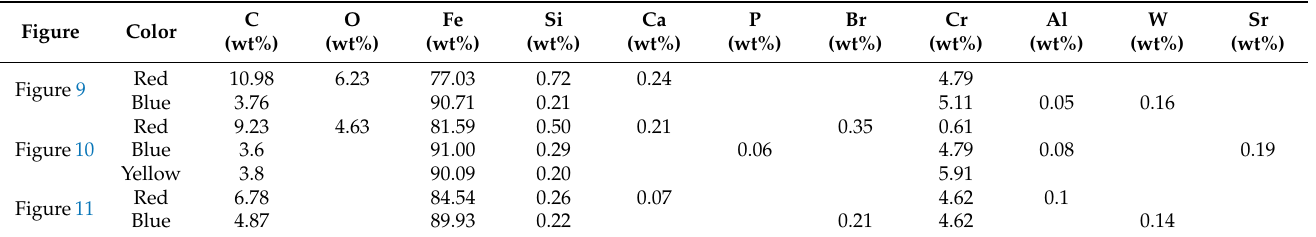
Figure 12. EDS of the wear delamination of bearings’ rolling elements (unserviced). Table 2. EDS of the wear delamination of high-performance bearings’ rolling bodies before and after the durability experiments.